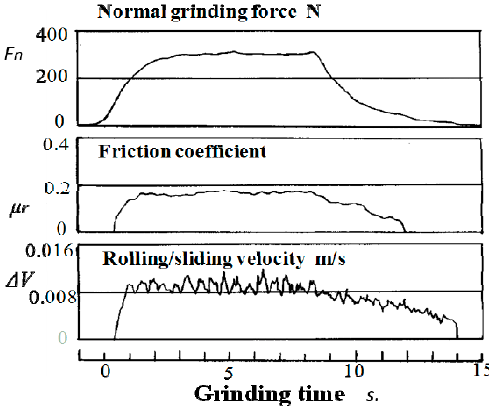
Figure 2. Infeed centerless grinding process. D r = 255 mm, D w = 30 mm, N r = 30 rpm, V w = 0.4 m/s, Sliding velocity: 0.008 m/s, Slippage ratio: 2%.